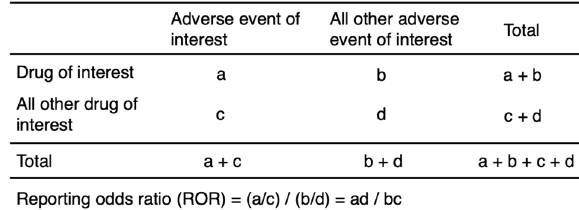
Figure 5. Two-by-two contingency